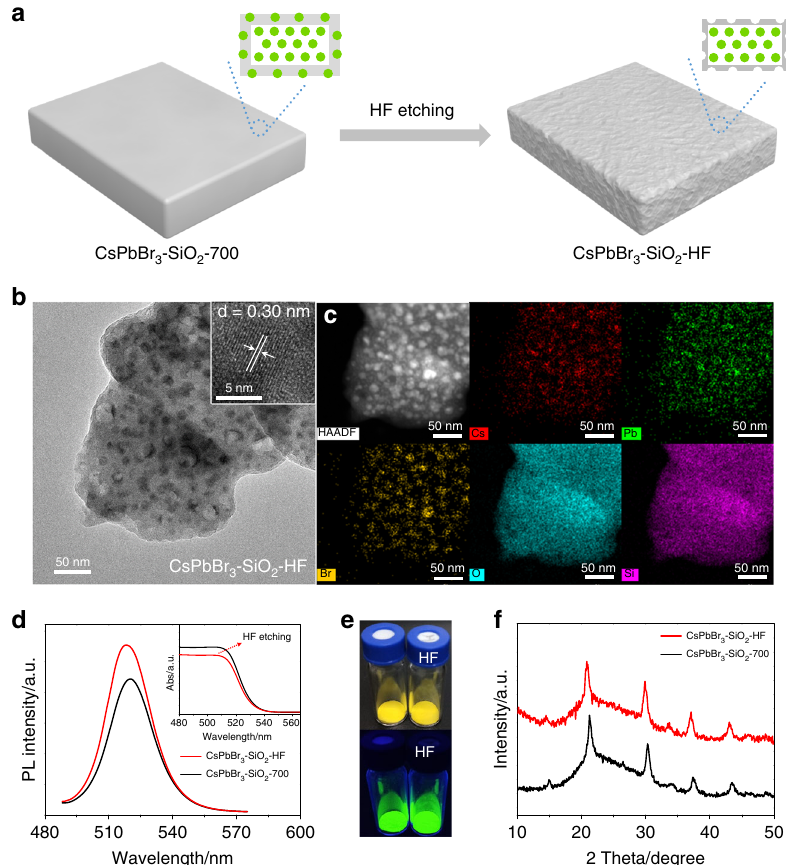
Fig. 4 Improving PLQYs by HF etching. a The schematic diagram of CsPbBr 3 -SiO 2 -700 by HF etching. b TEM image of CsPbBr 3 – SiO 2 – HF. c HAADF-STEM image of CsPbBr 3 – SiO 2 – HF and the corresponding elemental mapping of Cs, Pb, Br, O, and Si. d Photoluminescence emission and UV-Vis absorption spectra (insert) of CsPbBr 3 – SiO 2 – 700 and CsPbBr 3 – SiO 2 – HF. e Photographs of the CsPbBr 3 – SiO 2 – 700 powders (left) and CsPbBr 3 – SiO 2 – HF powders (right) under visible illumination (upper) and UV excitation at 365 nm (bottom). f XRD patterns of CsPbBr 3 – SiO 2 – 700 powders, and CsPbBr 3 – SiO 2 – HF